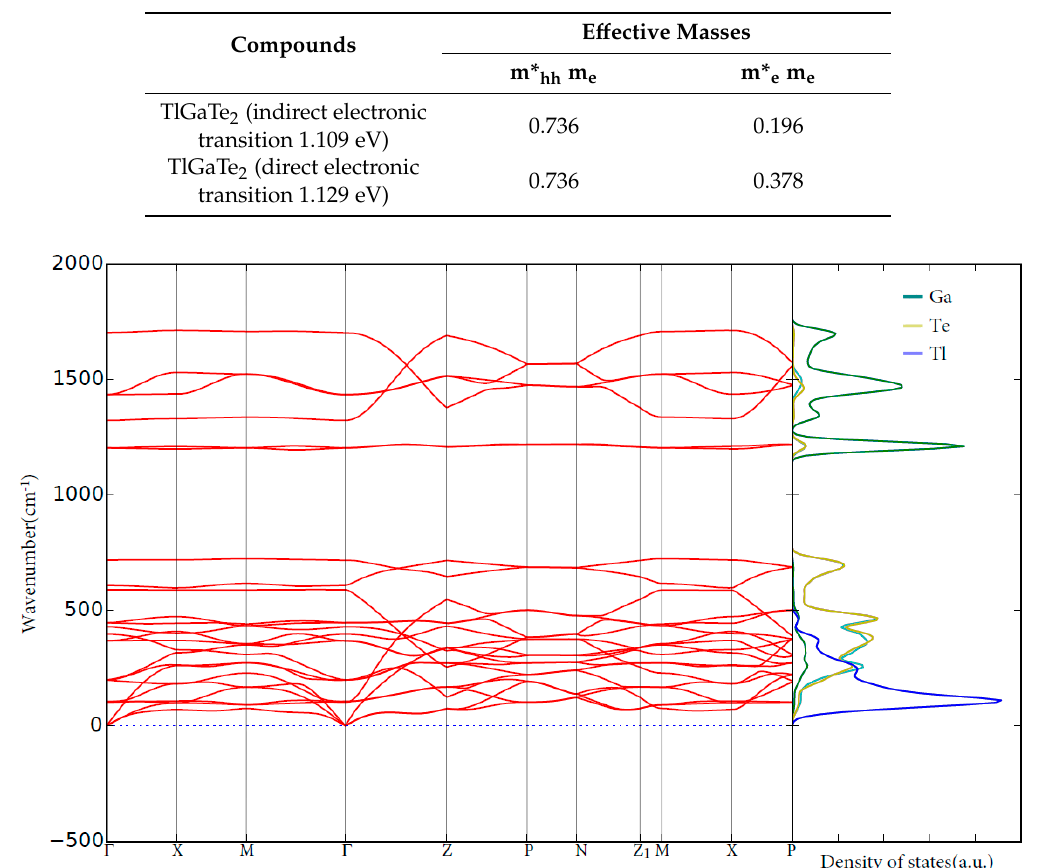
Figure 2. Calculated phonon spectra and site projected phonon density of states for TlGaTe 2 .